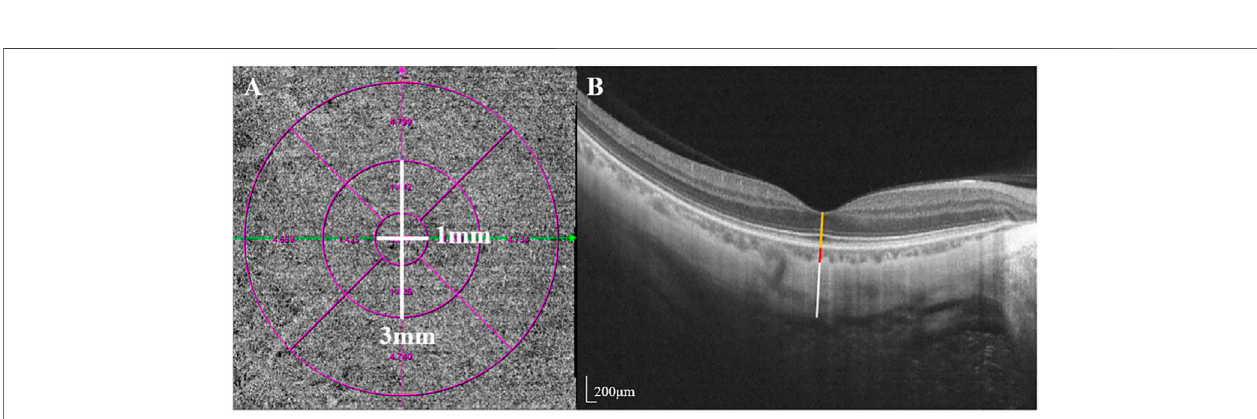
FIGURE2| Twoareasofmacularandmanuallymeasuredparameters(RT,CT,andST). (A) Thefovealregionwasacircularareawithadiameterof1 mm,centered on the fovea. The parafoveal region was a ring area around the fovea with an inner diameter of 1 mm and an outer diameter of 3 mm (B) Measurement of SFRT (yellow line), SFCT (red line) and SFST (white line). RT was de fi ned as the vertical distance between the inner limiting membrane and the retinal pigment epithelium. CT was de fi ned as the vertical distance between the outer edge of the retinal pigment epithelium (RPE) and the outer edge of the choroid. ST was de fi ned as the vertical distance between the outer edge of the choroid and the outer border of the